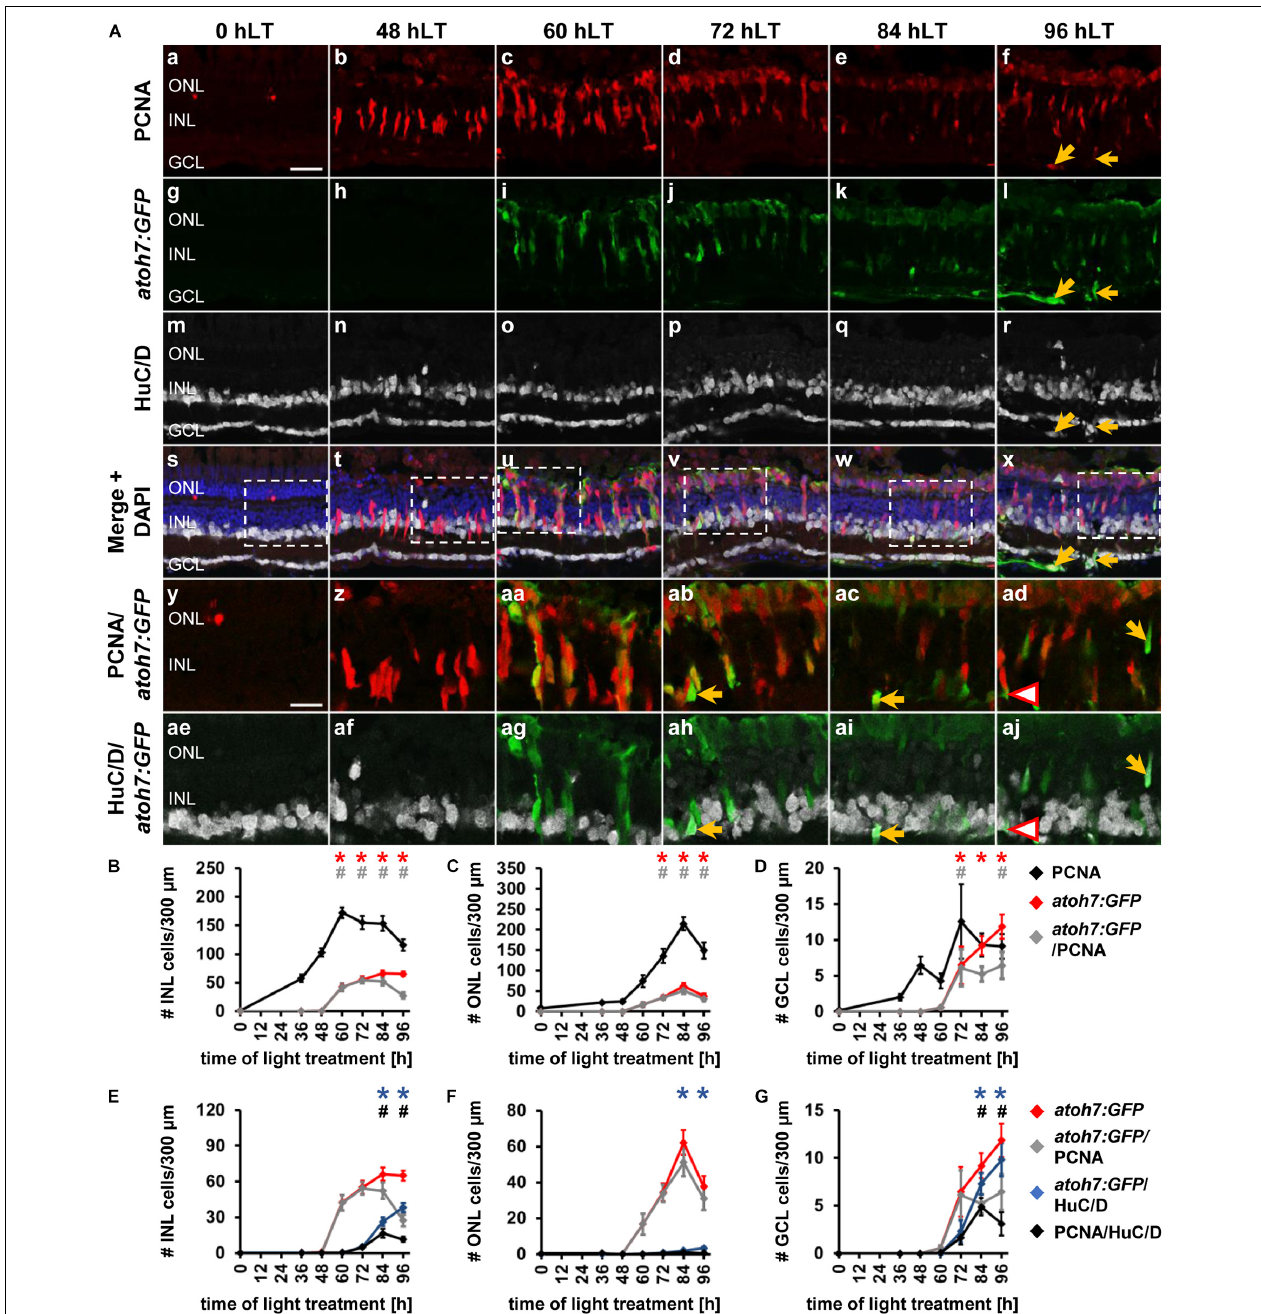
FIGURE 2 | Ganglion cell competence factor atoh7 is upregulated in the light-damaged retina. (Aa–aj) Single z -plane confocal images of retinal sections from light-damaged Tg[atoh7:GFP]rw021 zebrafish (0, 48, 60, 72, 84, 96 hLT) immunolabeled for PCNA (Aa–f,As–ad) , GFP (Ag–l,As–aj) , HuC/D (Am–x,Aae–aj) and counterstained with DAPI (As–x) . (Ay–aj) Regions outlined in panels (As–x) at higher magnification. Yellow arrows, atoh7:GFP , PCNA and HuC/D-triple positive cells. Red outlined arrowheads, atoh7:GFP and HuC/D-double positive cell that is PCNA-negative. Scale bars, 20 µ m (Aa) and 10 µ m (Ay) . (B–D) Number of PCNA-positive, atoh7:GFP -positive and PCNA and atoh7:GFP -double positive cells in the INL (B) , ONL (C) , and GCL (D) over the light treatment timecourse. (E–G) Number of atoh7:GFP -positive cells and atoh7:GFP and PCNA − double positive cells in comparison to atoh7:GFP and HuC/D-double positive and PCNA and HuC/D-double positive cells in the INL (E) , ONL (F) , and GCL (G) of retinas exposed to constant intense light for 0, 36, 48, 60, 72, 84, and 96 h. Mean ± SE, n ≥ 12, * p Tukey < 0.05 and # p < 0.05 indicate comparisons to 0 hLT for the different measures that were assessed. The symbols are color-coded according to the line that they represent in the corresponding graphs ( p ANOVA , see Table 1 ). Significance was not determined for PCNA in panels (B–D) and symbols indicating significance for atoh7:GFP and atoh7:GFP and PCNA-double-positive cells are not shown in panels (E–G) , as they are indicated in panels (B–D) . PCNA, Proliferating Cell Nuclear Antigen.